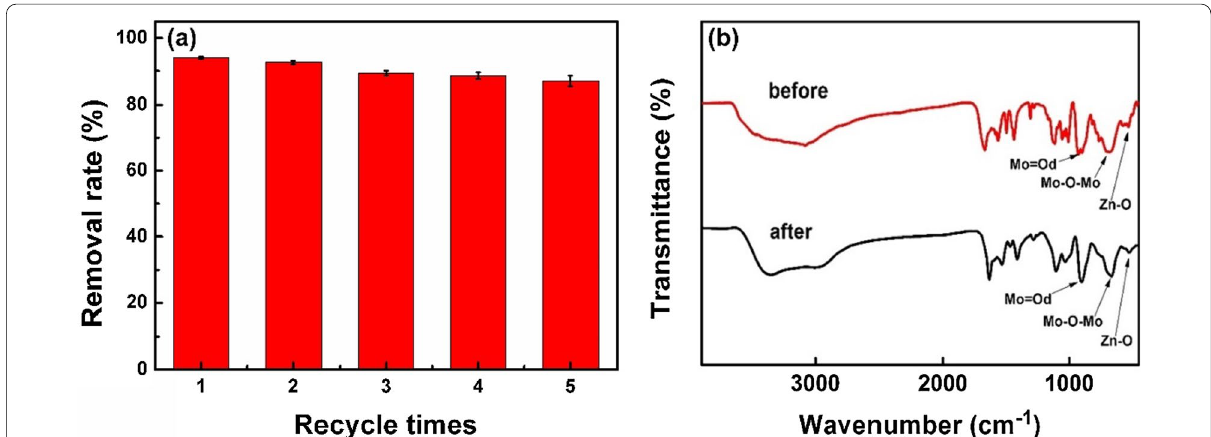
Fig. 11 a Histogram of recycle removal BM for 5 cycles (each cycle experiment was repeated three times), b Comparison of FTIR spectra of AgZnO/ POMs nanocomposites before and after 5 cycles